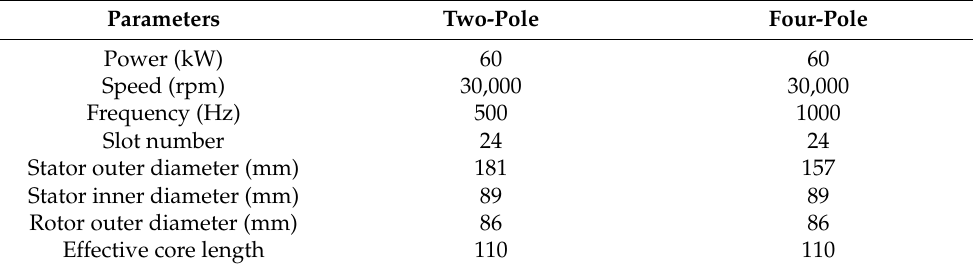
Table 4. Structural parameters of two-pole and four-pole motors for HSPMM. Parameters Two-Pole